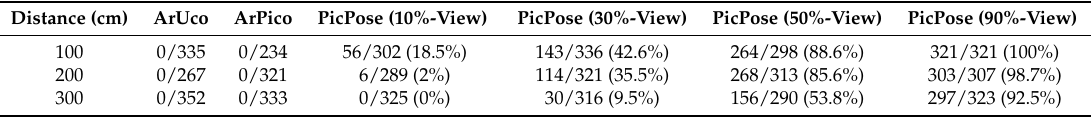
Table 4. Partially Visible Picture Pose Success Ratio.